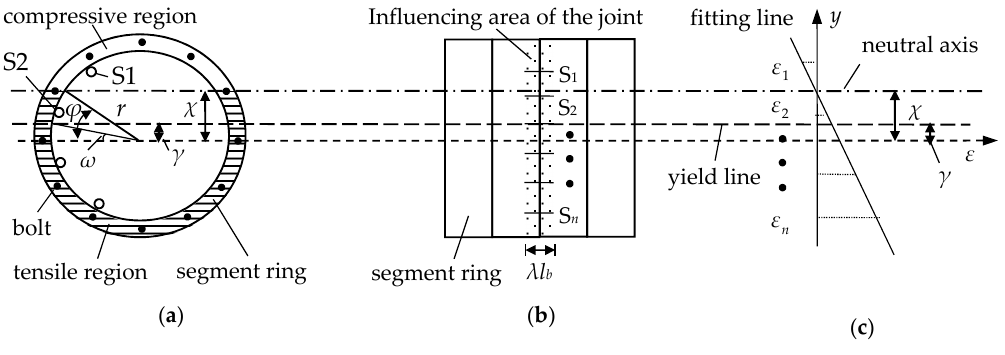
Figure 6. Determination of the NAD in a segment ring based on LFBG strain measurements. ( a ) Circumferential section; ( b ) Longitudinal section; ( c ) Fitting line based on LFBG measurements.